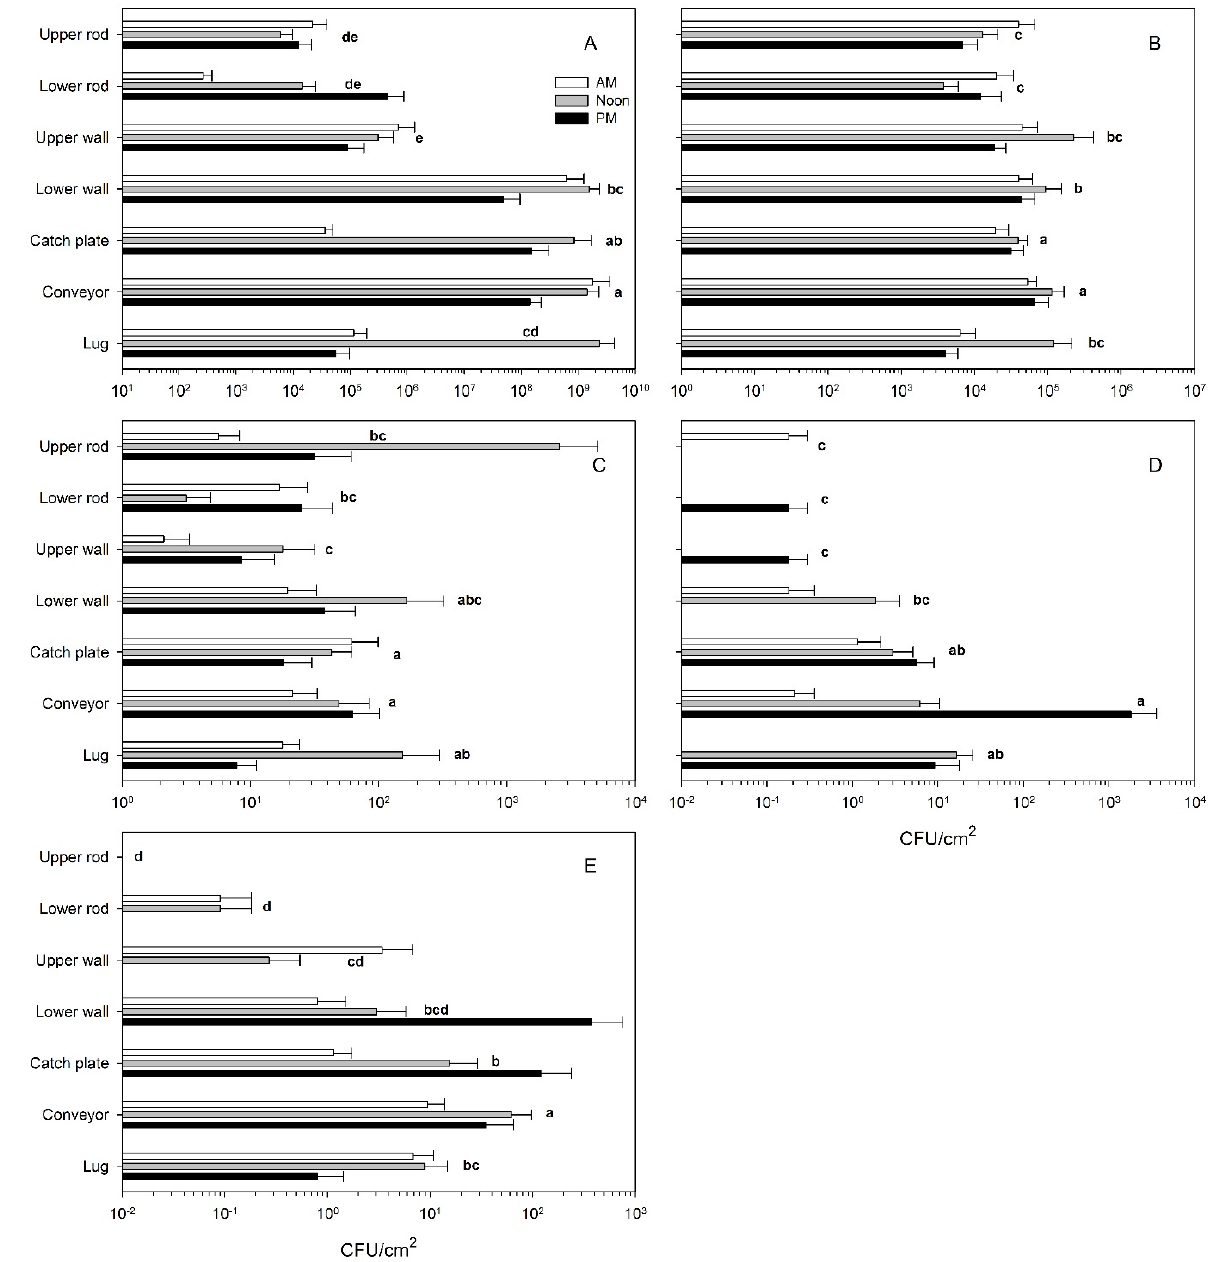
Figure 2. Microbial loads on different surfaces of blueberry mechanical harvesters in the field when sampled in the morning (AM), at noon, and in the evening (PM). ( A ) Total aerobes, ( B ) total yeasts and molds, ( C ) coliforms, ( D ) fecal coliforms, and ( E ) enterococci. Values are means and standard errors across seven harvesters sampled in each of 2 years. Bars with the same lower-case letters are not significantly different for comparison of the surface main effect (Tukey’s test, p = 0.05). Analysis based on log 10 ( x + 1)-transformed values, untransformed values are shown in the figures. CFU = colony-forming units.